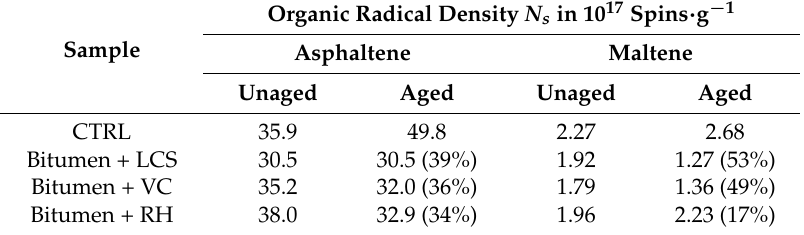
Table 2. Concentrations of paramagnetic centers N s determined in asphaltene and maltene fractions obtained both from unaged bituminous samples and after artificial aging through RTFOT. Relative concentration differences with respect to the aged CTRL have been also indicated in